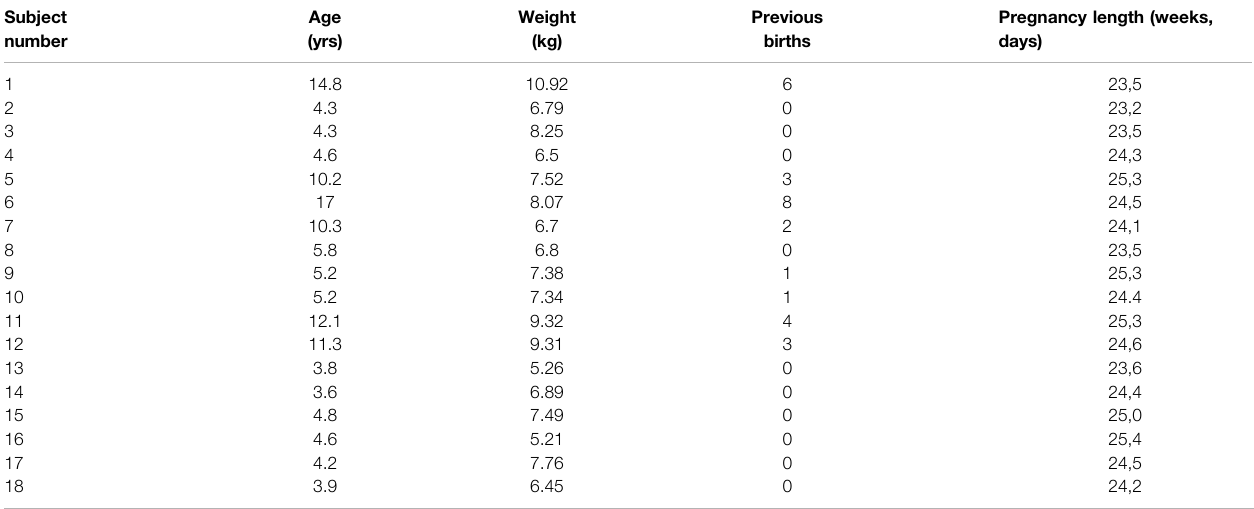
TABLE1| Characteristicsofthemacaques.Foreachmacaque,tissuemeasurementsweretakenintheanteriorandposteriorregionwithrespecttothecervicalcanalduring gestation weeks 10 and 23. Subject